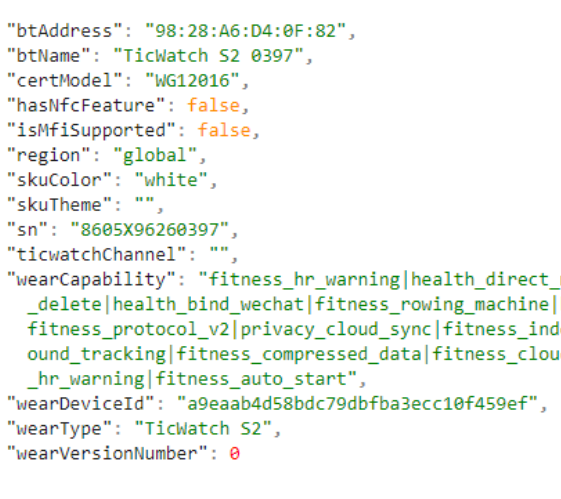
Figure 29. Reduced and formatted device information for the